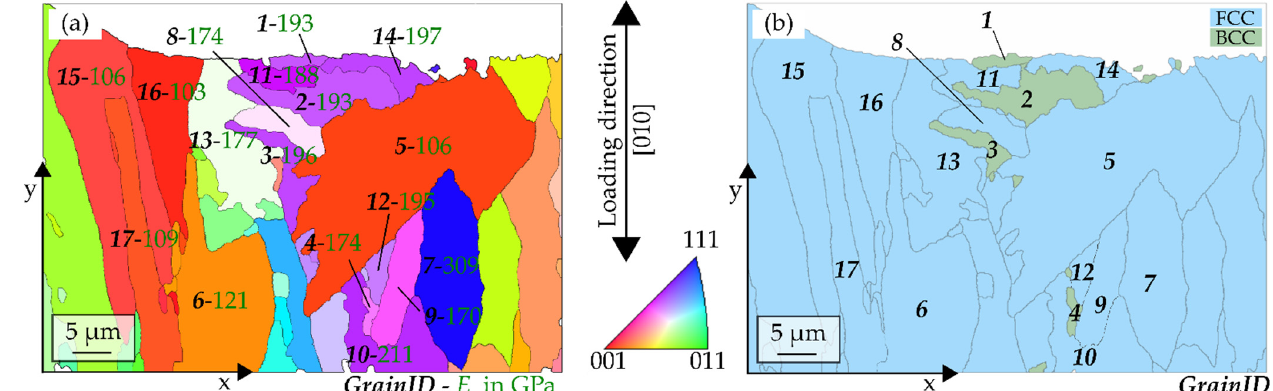
Figure 5. Illustration of the calculated initial austenitic microstructure (parent microstructure) including the information of the Young’s modulus E in GPa of selected grains ( a ) and the corresponding microstructure calculation, showing the deformation-induced phase transformation ( b ).